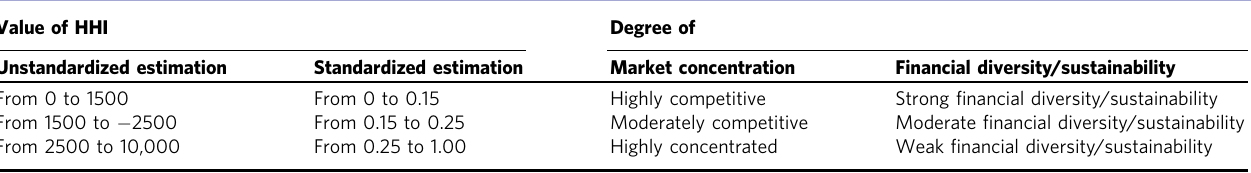
Table 1 Classi fi cation of market concentration and fi nancial diversity according to the value of HHI. Value of